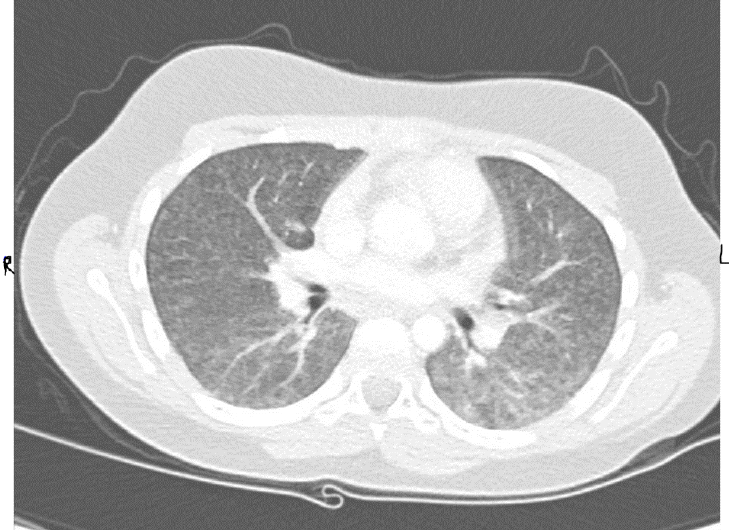
Figure 2. Patient CT scan of the chest showed diffusely reticular-nodular opacities in both lungs involving lung bases and the posterior segments of the right and left upper and lower lobes with irregular bronchovascular marking.